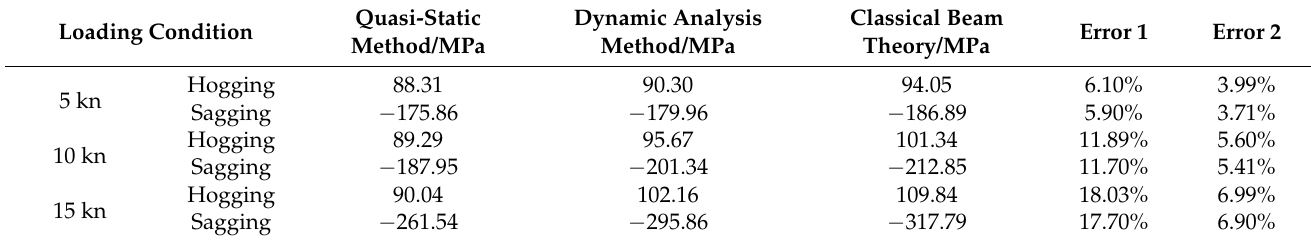
Table 5. Bending stresses from different methods (with slamming effect).